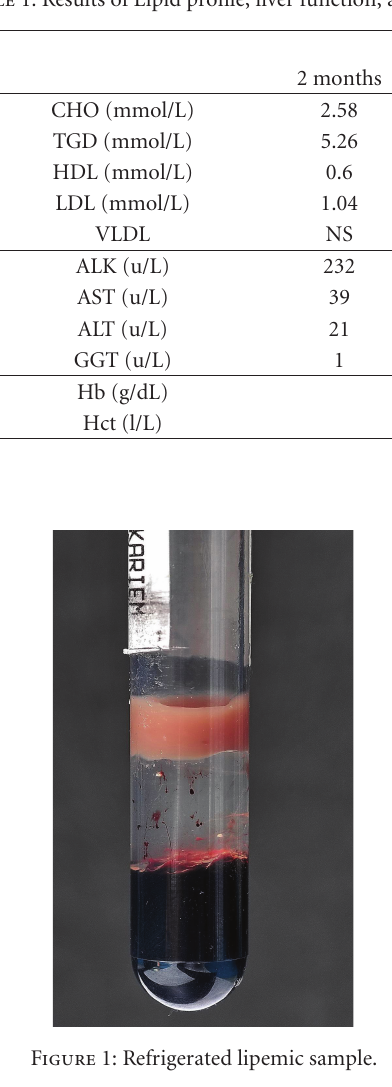
Table 1: Results of Lipid profile, liver function, and complete blood count for AA at 2 months, 18 months, 2 years, and 4 years.